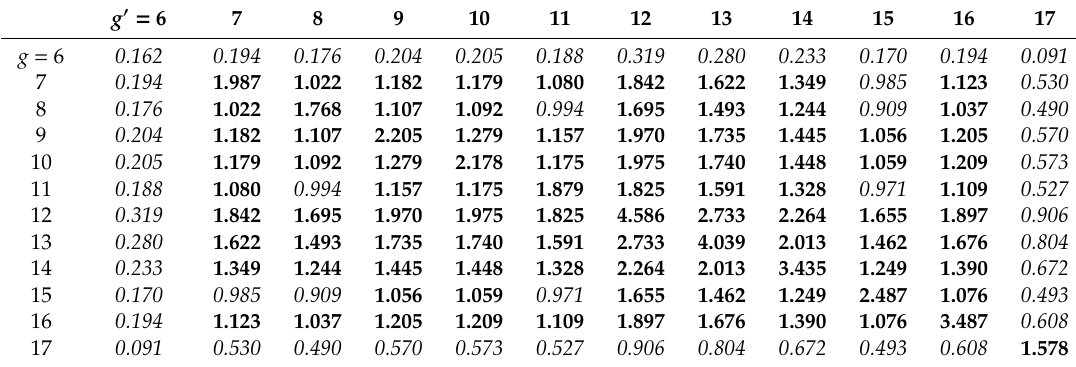
(cid:16) (cid:17) (cid:48) σ g , σ g , g , g (cid:48) = 1, ... ,30 having values greater than 1.0. t , i = 1 t , k = 1